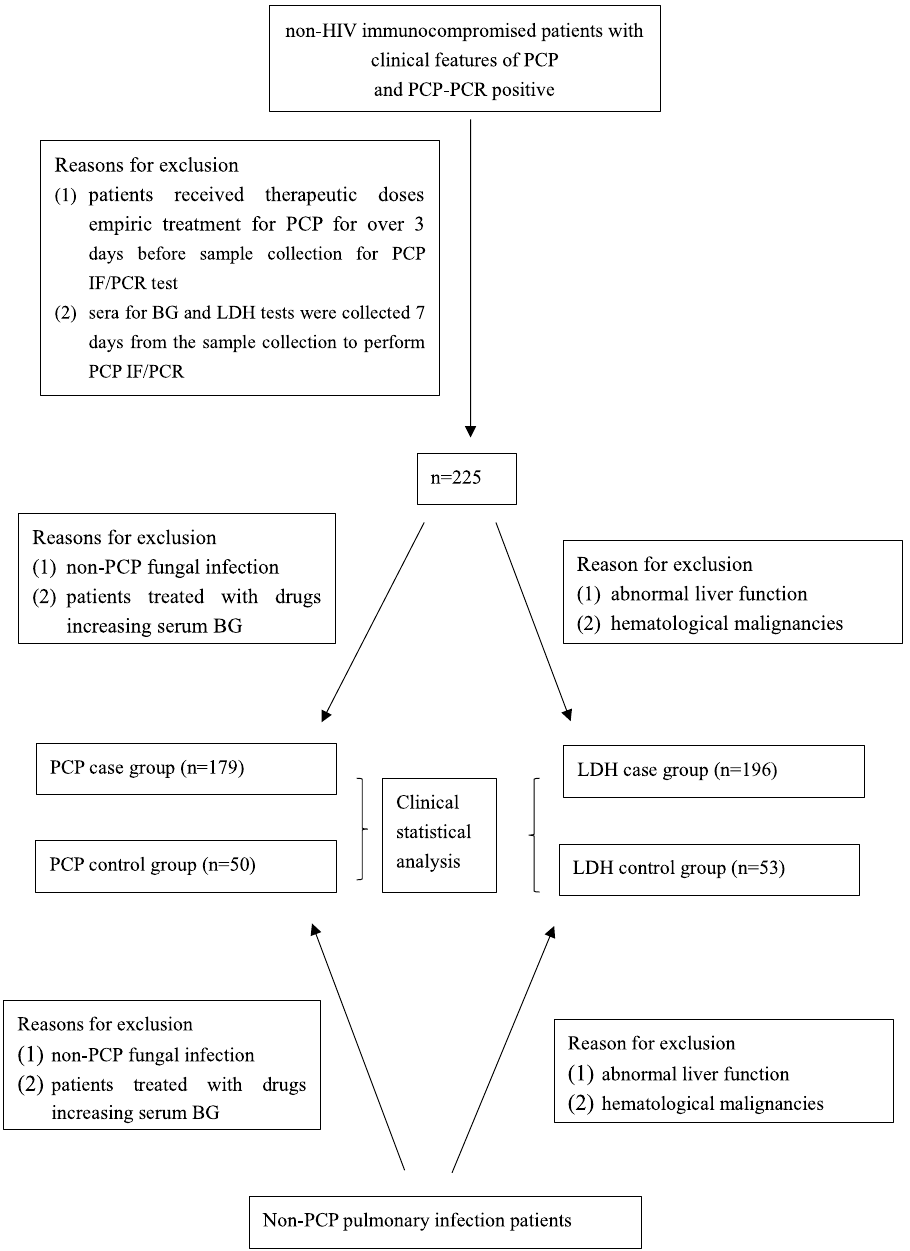
Figure 1. patients sample flow. HIV human immunodeficiency virus, PCP pneumocystis pneumonia, PCR polymerase chain reaction, IF immunofluorescence, BG (1–3)-beta-d-glucan, LDH lactate